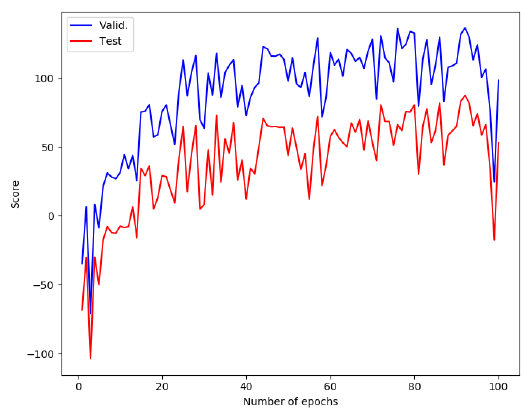
Fig. 10. Typical PV production in summer